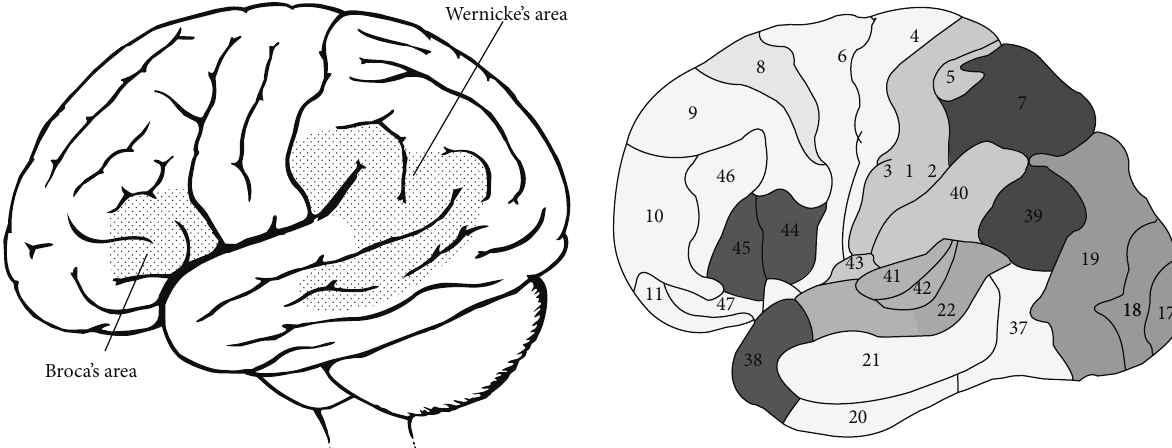
Figure 1: Traditionally it has been accepted that there are two major areas involved in language: frontal Broca’s area (BA44 and probably BA45) and temporal Wernicke’s area (BA22, 21, and 37, although BA39 is also frequently included.).